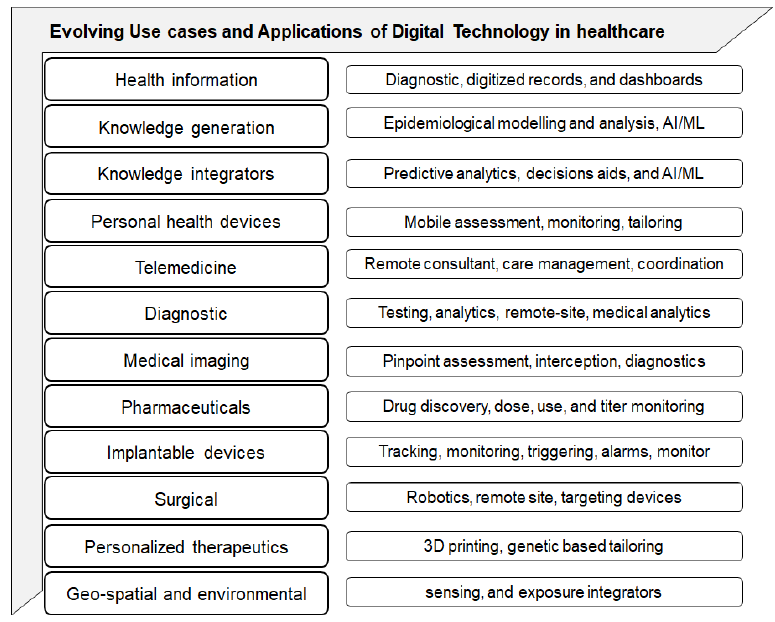
Figure 2. Practical applications of digital technologies in the healthcare